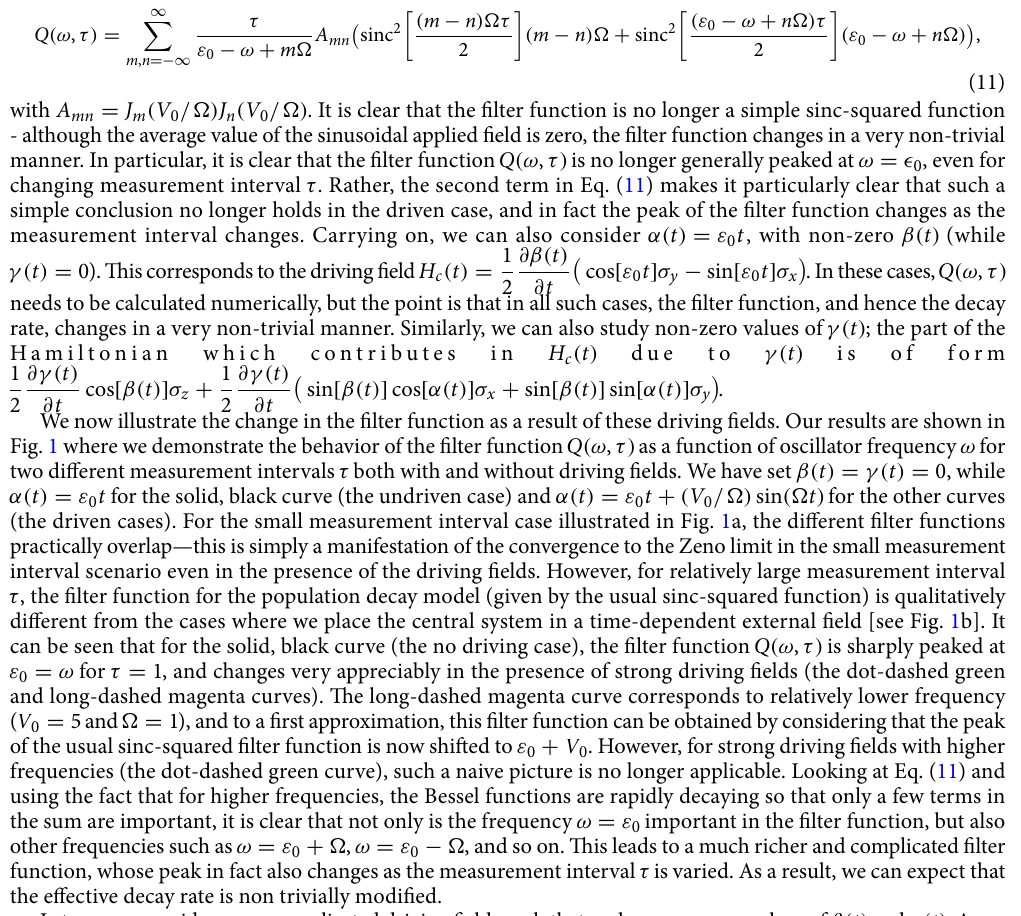
Figure 1. Filter function for the driven population decay model with the RWA. ( a ) Graph of Q (ω , τ) versus ω ε 0 t ( V 0 /�) sin (� t ) , β( t ) in the presence of time-dependent driving fields: α( t ) = + 1 and (cid:31) 5 and (cid:31) 5 (dashed, red curve), V 0 1 (large-dashed, magenta curve), and V 0 V 0 = = = = 0 and γ(τ) 0 for the solid, black curve. Throughout, we ε 0 τ , β(τ) (dot-dashed, green curve). α(τ) = = = 1 . Here we have used a relatively small measurement 1 and we have set ε 0 use dimensionless units with (cid:31) = = 0.1 . ( b ) Same as ( a ), except that now τ 1 interval, that is, τ = =